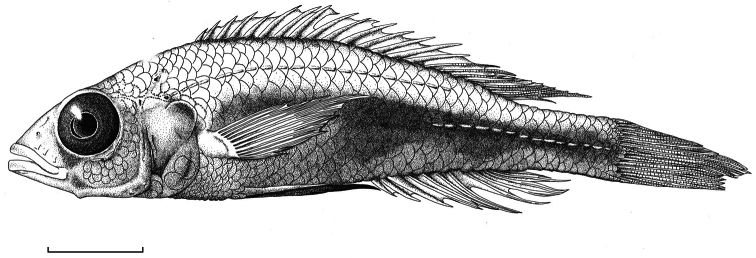
Habitus of Haplochromis goldschmidti sp. n. ♂ (holotype, RMNH.PISC.83573). Scale bar equals 10 mm. Drawing by I. Westbroek, missing (= dotted) scales added by M. van Oijen.